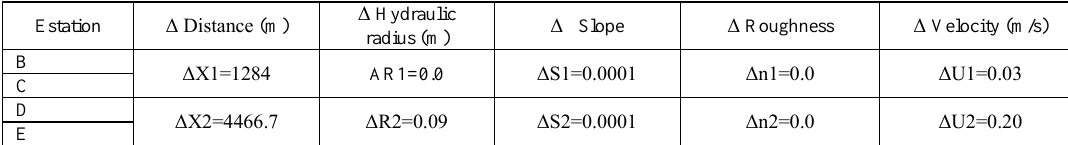
Table 2. Table of differences in parameters as a function of distance